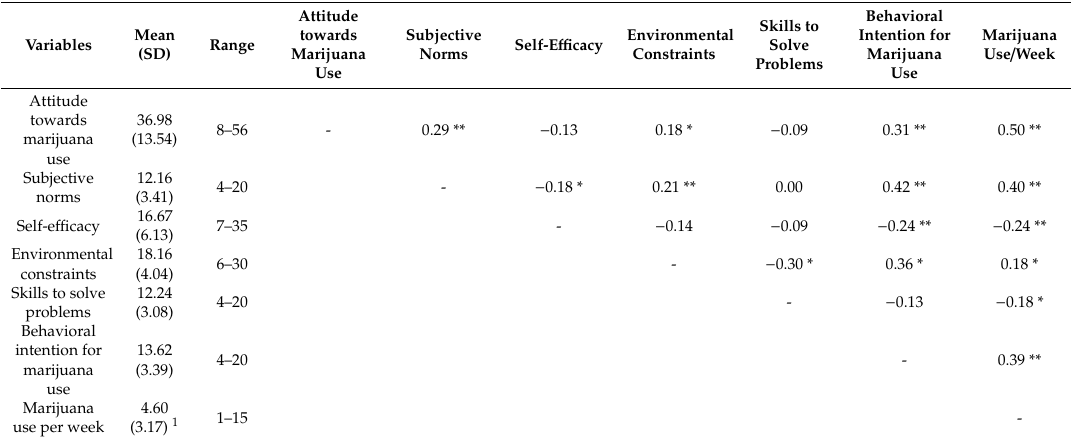
Table 4. Descriptive statistics and correlation coe ffi cients of the six dimensions of the Theory of Planned Behavior (TPB) and the mean marijuana use per